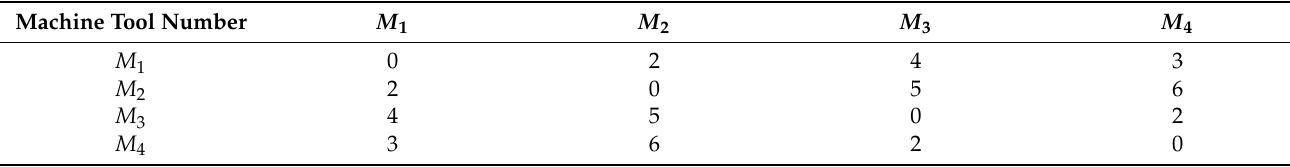
Table 2. Transferred times between machines (unit: